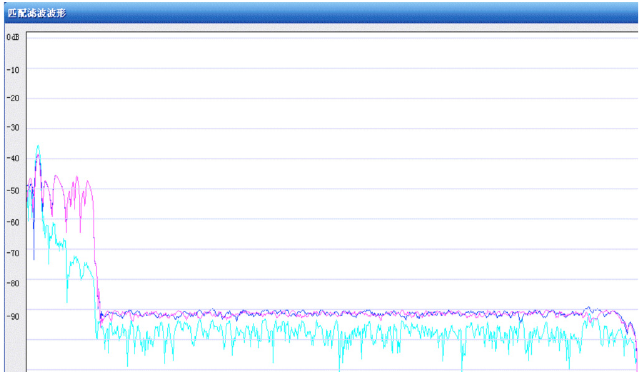
Figure 8. Result of the digital pulse compression processing.